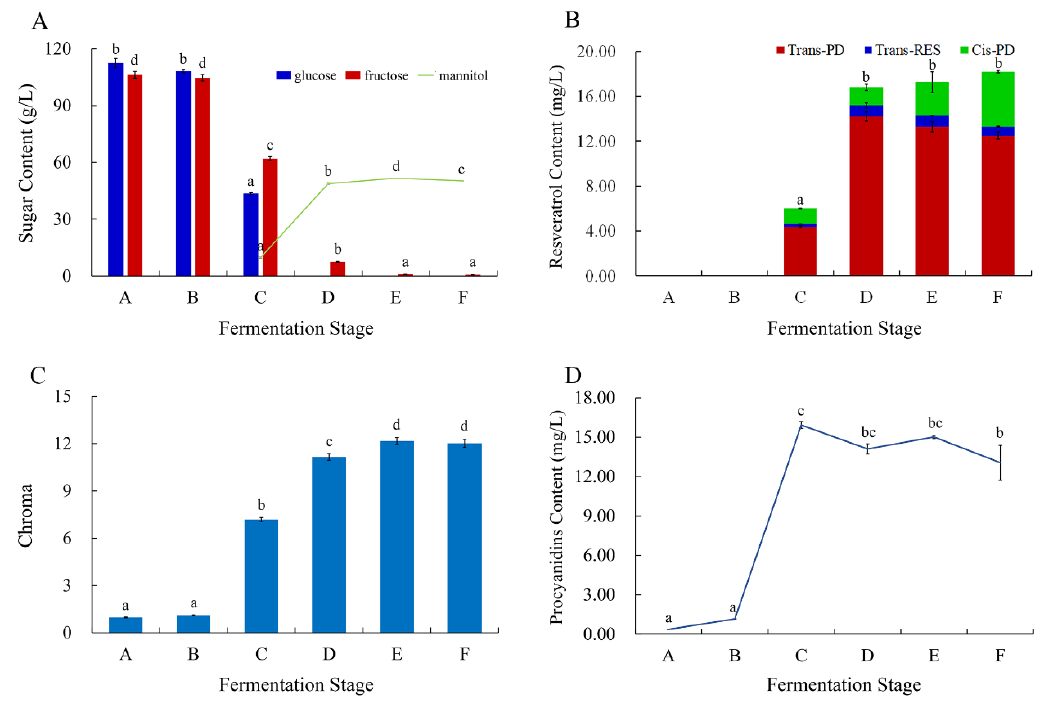
Figure 9. Changes of sugar ( A ), resveratrol ( B ), chroma ( C ) and procyanidins ( D ) content during Beimei red winemaking. Letters A to F on X-axis represent different fermentation stages during the winemaking of Beimei red wine. The data are mean values of three replicates. The error bars indicate SE from repeats. All letters above the bars indicate significant differences ( p < 0.01, determined by one-way ANOVA).